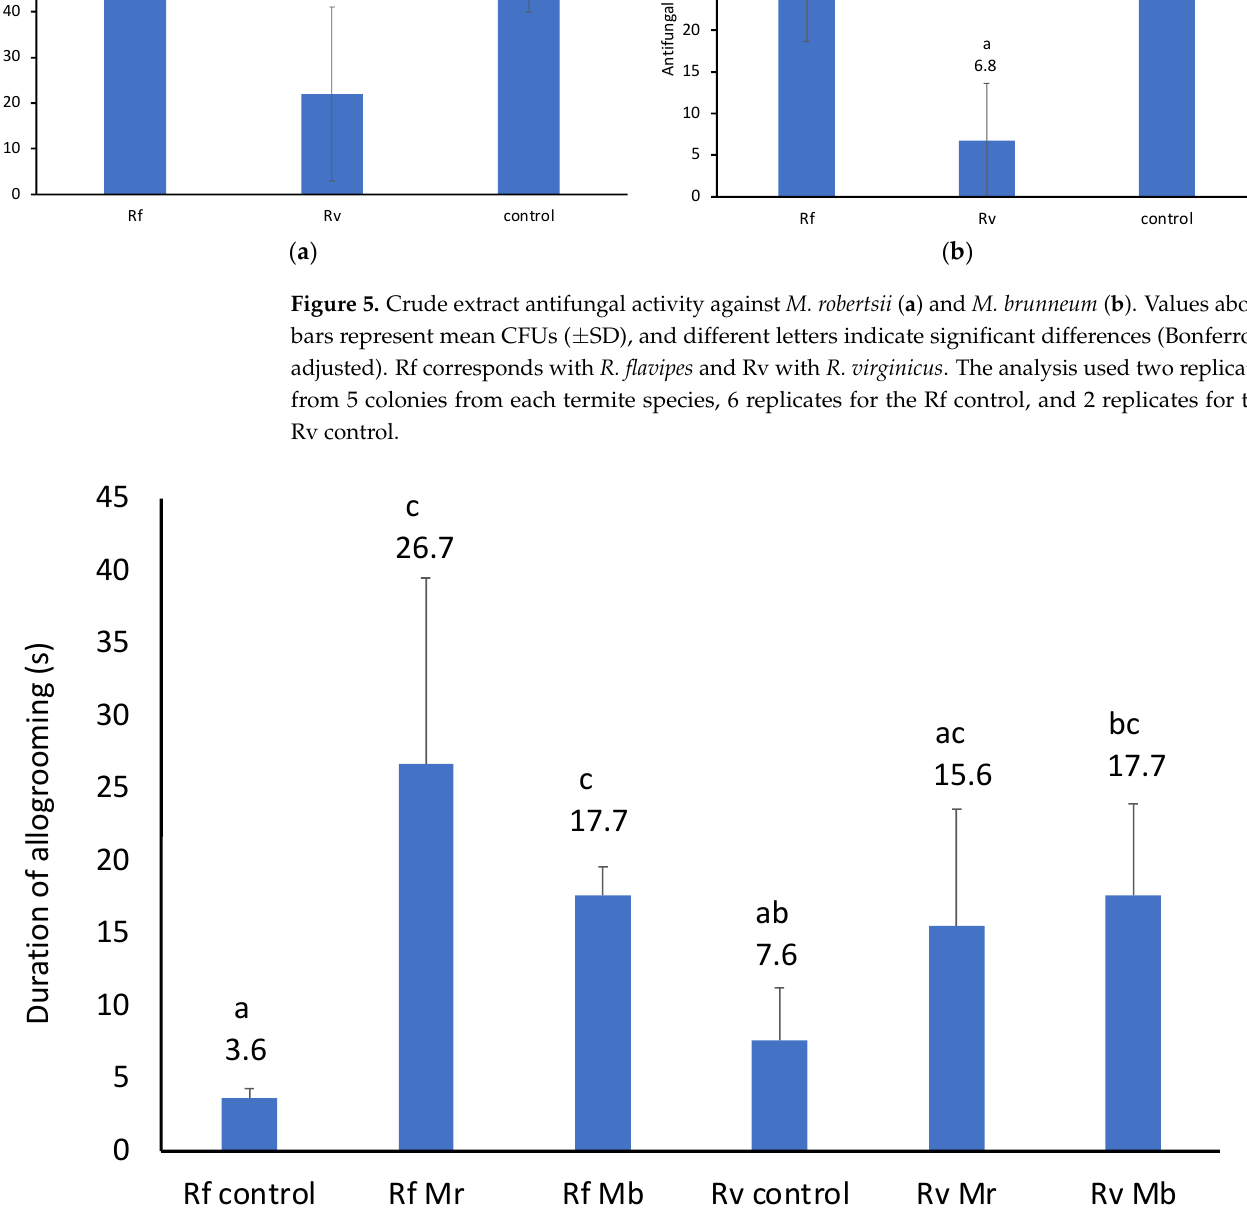
Figure 6. Duration of allogrooming per interaction (n = 161 allogrooming events). Values above bars represent mean duration of allogrooming interactions ( ± SD), and distinct letter combinations indicate significant differences (Bonferroni adjusted). Rf corresponds with R. flavipes , Rv with R. virginicus , Mr with M. robertsii , and Mb with M. brunneum .